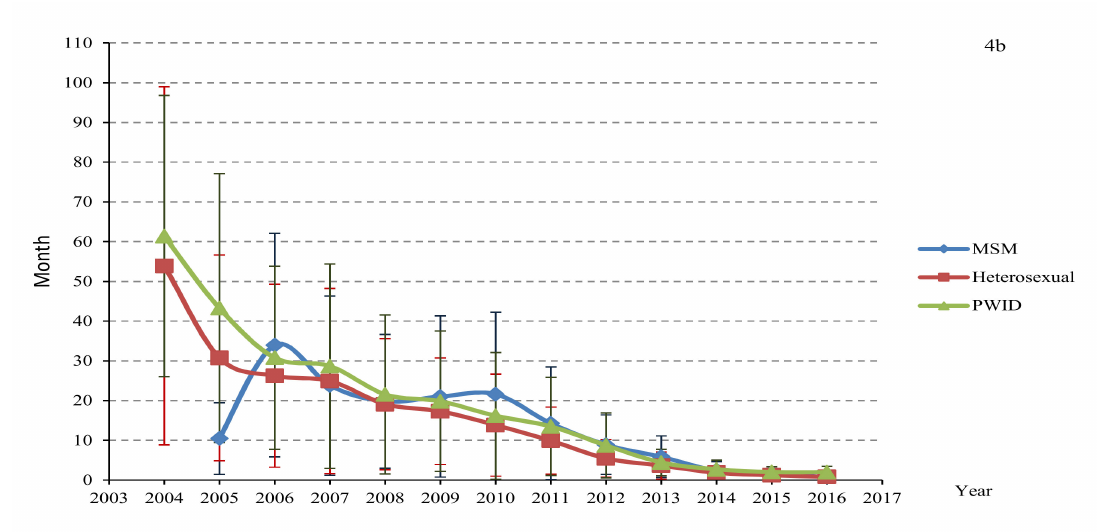
Figure 4. The CD4 counts at diagnosis ( a ) and lag time between HIV diagnosis and initial ART ( b ) by transmission